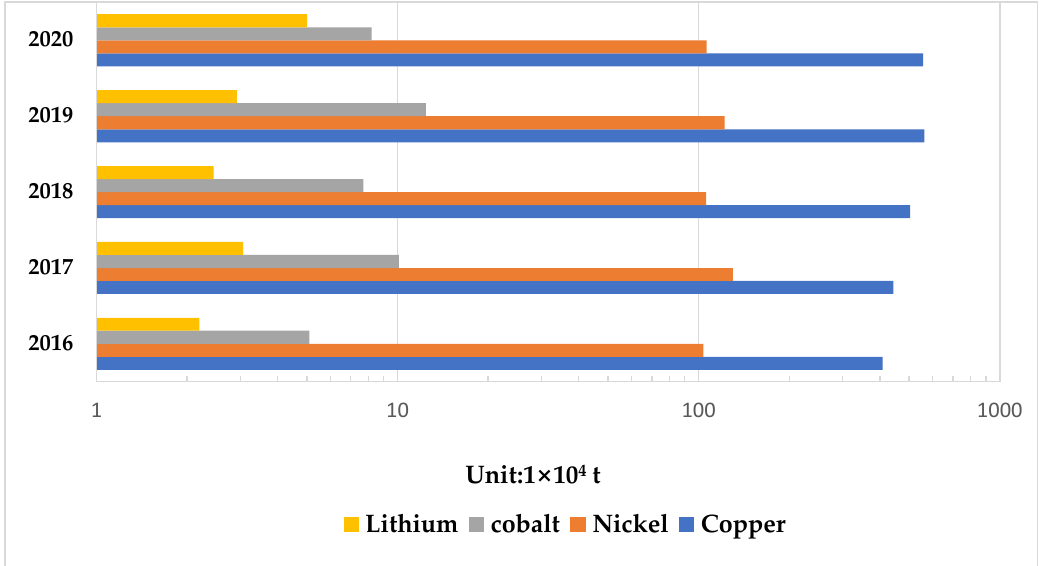
Figure 6. China’s overseas imports of mineral resources in 2016 – 2020 (Data Source: [29]). Table 10. Proven resource reserves of China’s mineral resources in 2016 – 2020 (Unit: MT) (Data Source: [27]).